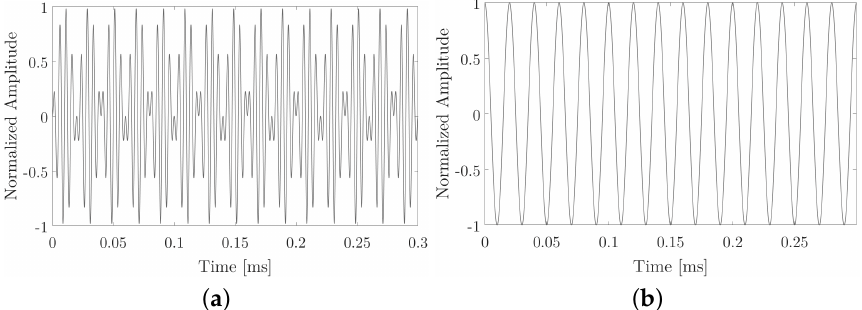
Figure 2. Bit 1 example. ( a ) PSK modulation. ( b ) PSK type signals that want to obtain parametrically, in this case, this signal is also equal to bit